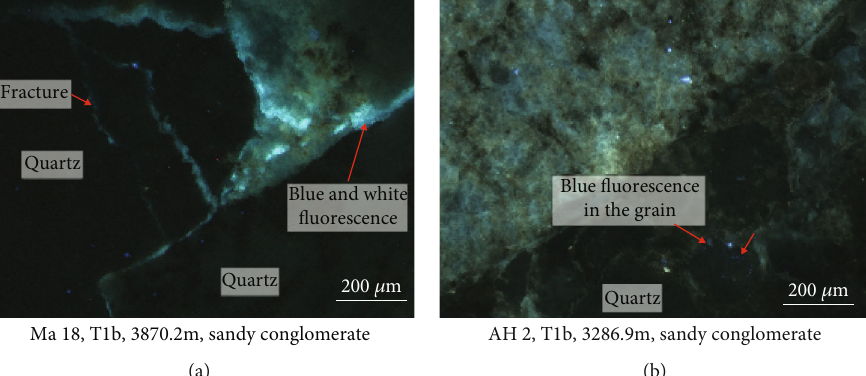
Figure 7: Fluorescence microscopy photographs showing the oil migration pathways in the Baikouquan